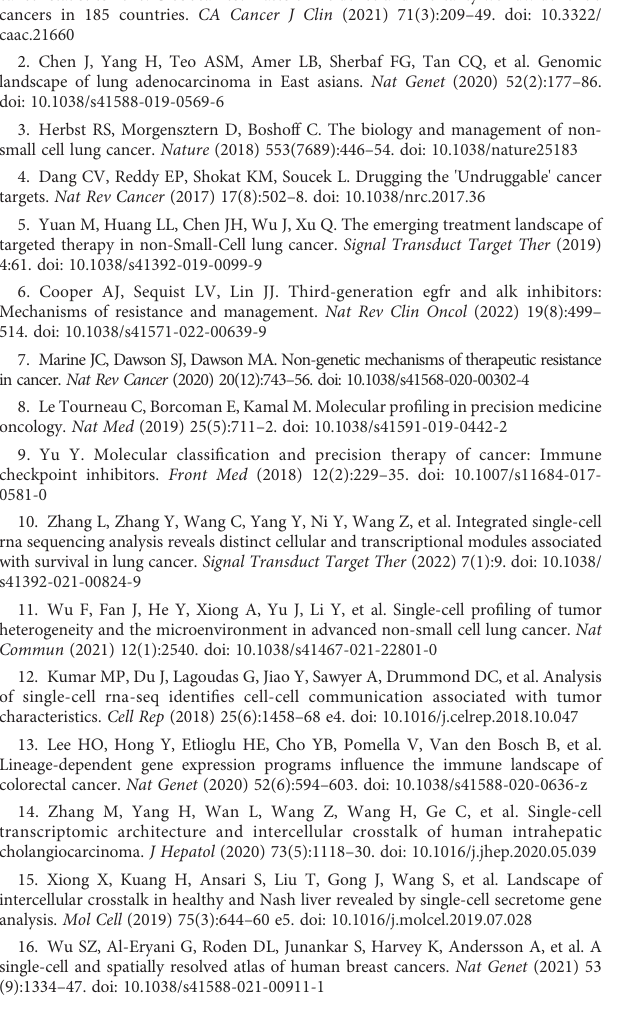
the “ irGESA ” algorithm. (F) Dotplot showing the relative expression of representative reported immune response genes and other representative genes in each cell type in nonresponder vs. untreated patients, responder vs. untreated patients, and responder vs. nonresponder. SUPPLEMENTARY FIGURE 2 Flow cytometry analysis the cell type in LUAD with anti-PD-L1 treatment. (A) APC Mouse Anti-Human CD326 staining (BD Pharmingen ™ ) to sort the epithelial cells in the responders and non-responders (Left: APC-Black; Right: APC-CD326) (B) PE Mouse Anti-Human CD163(BD Pharmingen ™ ) to sort the macrophage cells in the responders and non-responders (Left: PE- Black; Right: PE-CD163). SUPPLEMENTARY FIGURE 3 Correlation between L-R score mutation characteristics and immune-related characteristics. (A, B) Heatmap showing the top 20 gene mutation frequencies in the high- and low-risk groups in LUAD. (C) Analysis of the immune cell scores between the different L-R score groups using the CIBERSORT algorithm, distribution, and expression of the 22 types of immune cells in the TCGA-LUAD